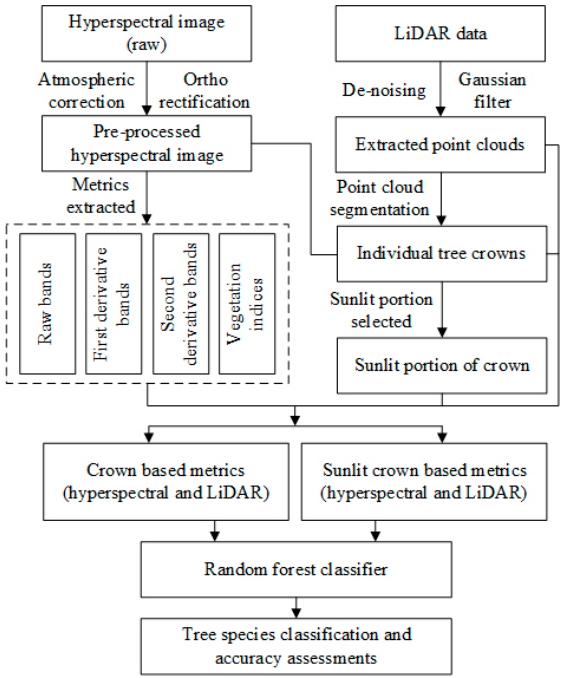
Figure 1. An overview of the technique route for tree-species classification using hyperspectral and LiDAR data.